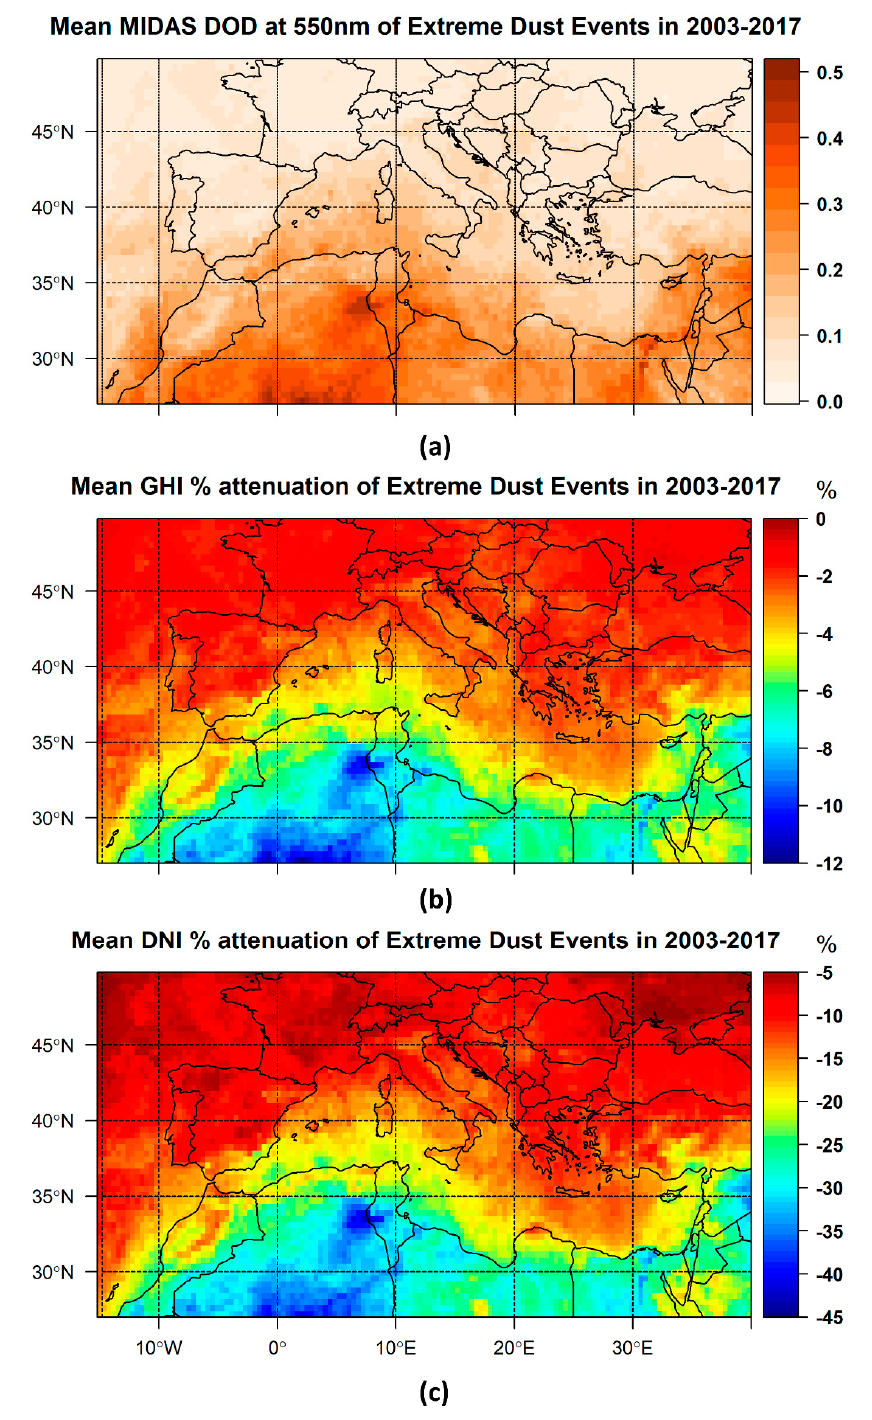
Figure 11. Geographical distribution of mean MIDAS DOD at 550 nm for extreme dust episode days (eDEDs) ( a ) and the corresponding GHI ( b ) and DNI ( c ) change (in %).